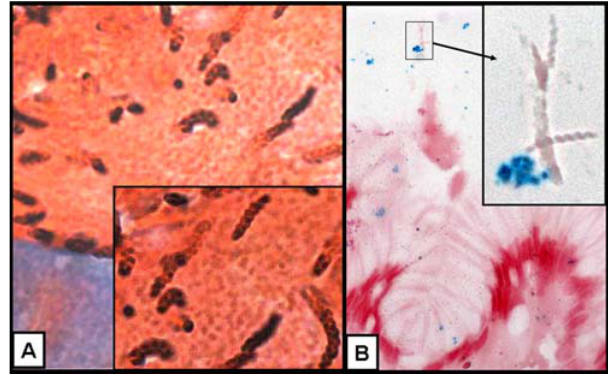
Figure 4. Gastric biopsy of a rhesus monkey with H.pylori and H. heilmannii co-infection. Genta stain (A: 400X; insert: 1,000X) demonstrates the presence of high H. heilmannii infection (typical tightly spiraled, , 10 m m-long rods), in addition to a few H. pylori –like bacteria ( , 3 m m-long and curved). In situ hybridization (ISH) with 16S rRNA probe (B: 400X; insert: 1,000X) demonstrates the presence of H. pylori (stained blue by the avidin alkaline phosphatase (nitroblue tetrazolium) while other, tightly spiraled bacteria are